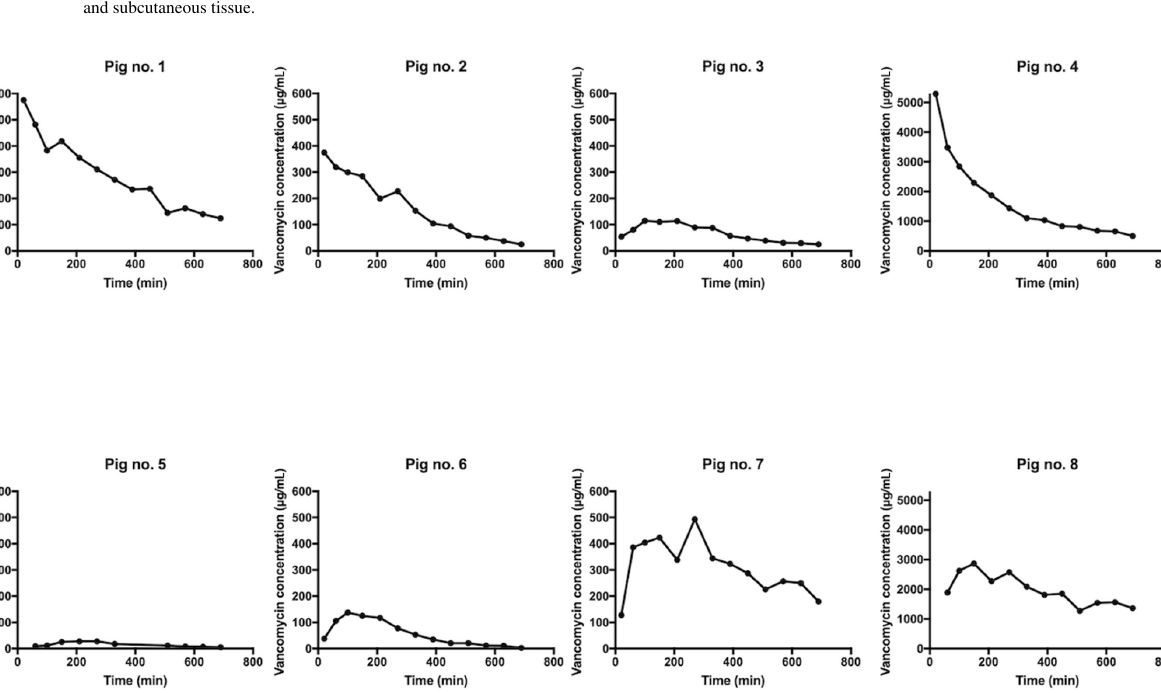
AUC 0 − last : area under the concentration–time curve from 0 to the last measured value; C max : peak drug concentration; T max : time to C max ; T 1 / 2 : half-life at phase. a p > 0 . 35 for all pairwise comparisons of means between the intramedullary canal, synovial fluid of the knee joint, and subcutaneous tissue.